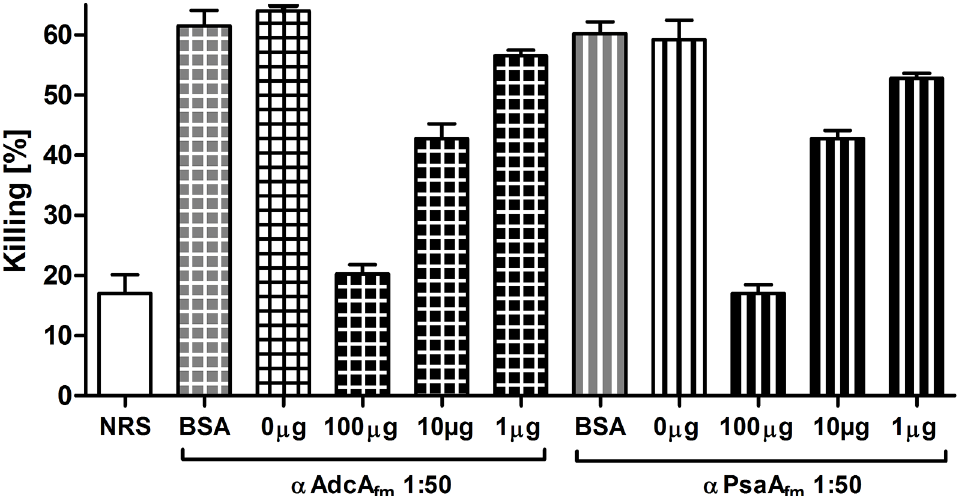
Fig 3. Specificity of antibodies raised against recombinant proteins AdcA fm (square grid) and PsaA fm (vertical stripes). Sera were used at final dilution of 1:50 and the strain tested was E . faecium E155. Purified recombinant proteins were used as inhibitors at a final concentration of 100 μ g/mL, 10 μ g/ mL and 1 μ g/mL. BSA at final concentration of 100 μ g/mL was used as negative control. The mixtures serum-protein were pre-incubated 1 hour at 4°C prior to OPA. Opsonic killing of the target strain with non-absorbed antibodies was used to assess the reduction of opsonic killing produced by each inhibitor. The corresponding dilutions of antibodies and inhibitor used in the OPA are indicated in the abscissa and the % killing in the ordinate. Bars represent the mean of data and the error bars represent the standard error of the mean.